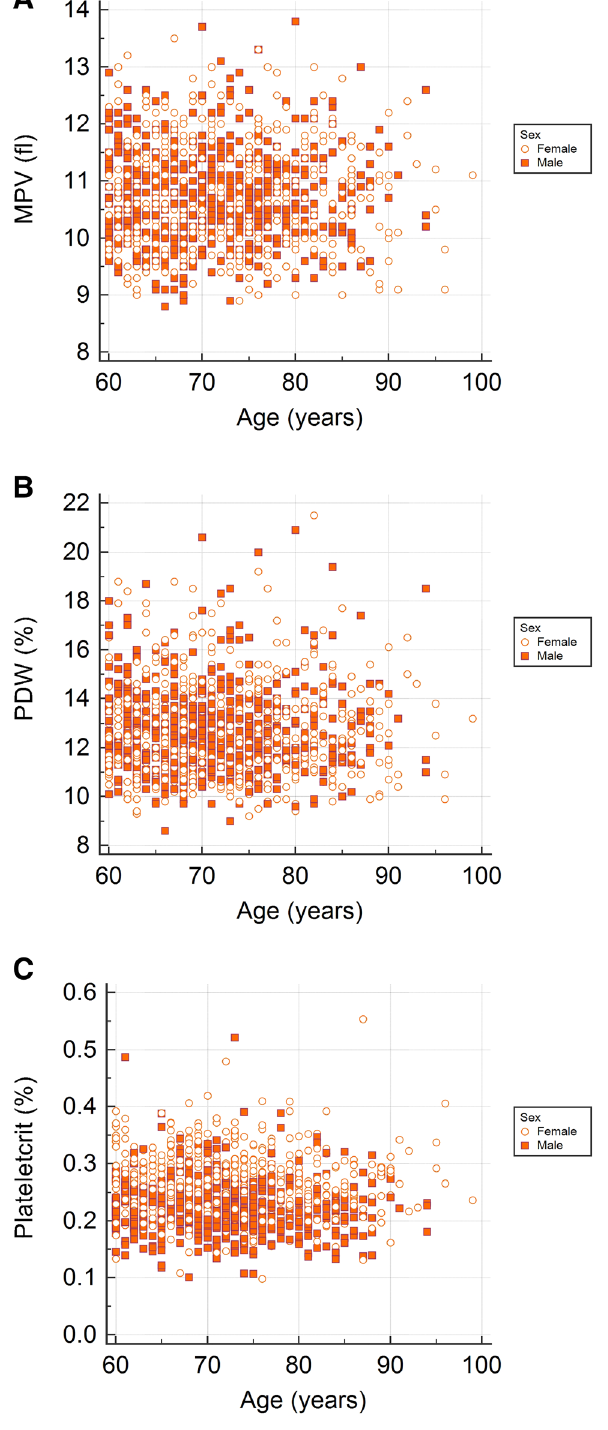
Figure 1: Mean platelet volume, MPV. (A), platelet distribution width, PDW, (B), and plateletcrit, PCT, (C), strati fi ed according to age and gender.